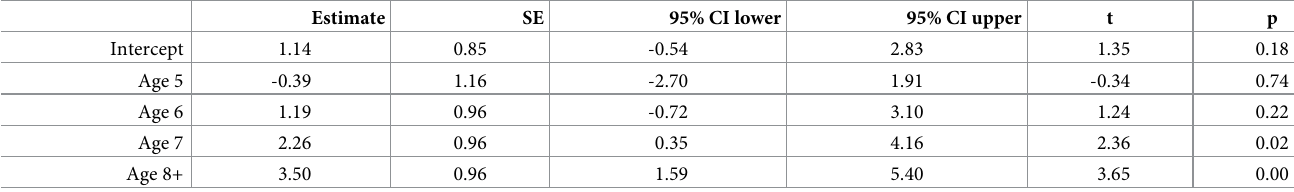
Table 5. Output for regression: Giver-Level � Age. Age is a dummy-coded, categorical predictor. Estimate SE p